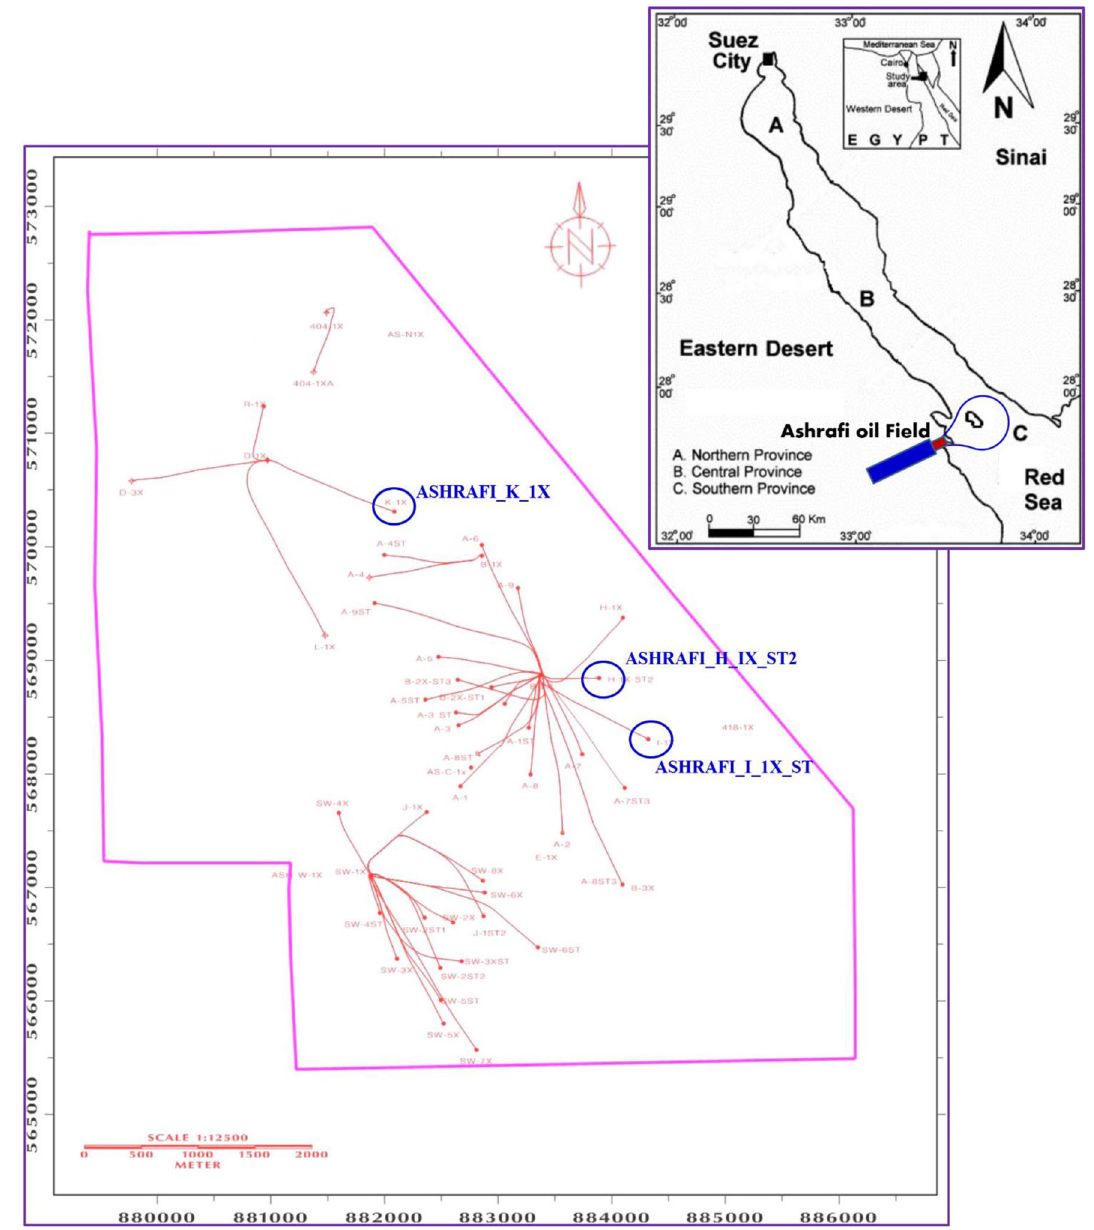
Fig. 1 Location map of the studied wells in Ashrafi Field, Gulf of